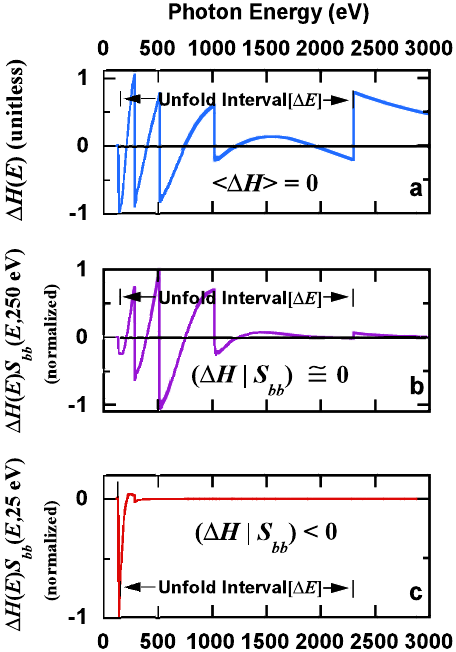
FIG. 5. Products of (cid:1) H ð E Þ with various Planckian spectra. Part (a) plots (cid:1) H ð E Þ alone, while (b) and (c) show the products, E; 250 eV Þ and (cid:1) H ð E Þ S E; 25 eV Þ , respectively. (cid:1) H ð E Þ S bb ð bb ð